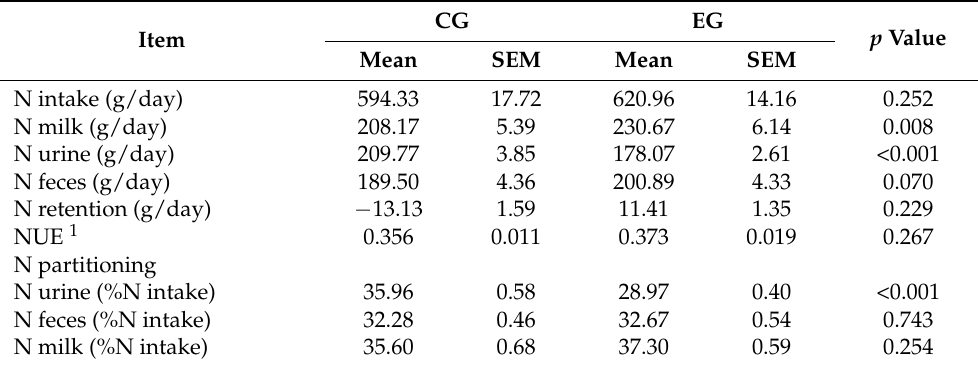
Table 5. Mean values ± SEM of Nitrogen Balance of dairy cows grouped by low (CG) or high (EG) locomotion